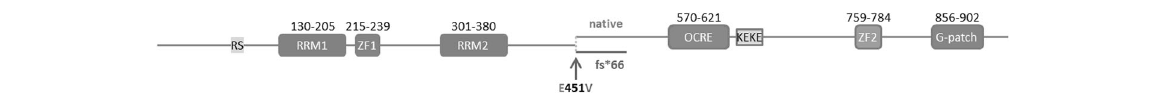
Fig. 2 Domain structure diagram of RBM10 showing locations of domains (grey rectangles) and sequence biased regions (grey squares). Position of alteration shown with teal arrow, native sequence lost due to this alteration outlined in red, and the alternative 66 amino acid C-terminal sequence gained is depicted as a teal line. No structure or function was identified for this gained